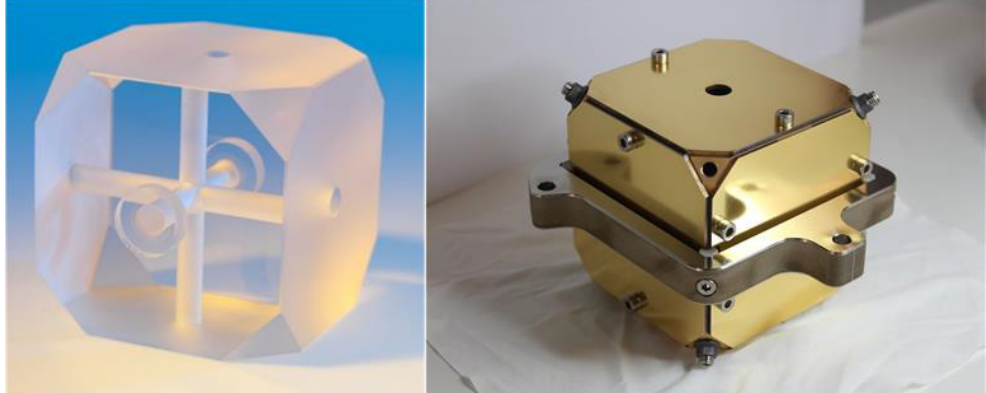
Figure 6. Left: cubic ULE spacer with 5 cm length. Right: titanium mounting frame with the first gold-coated heat shield, holding the ULE spacer in place via a tetrahedral mounting arrangement (image credit: NPL London, UK).